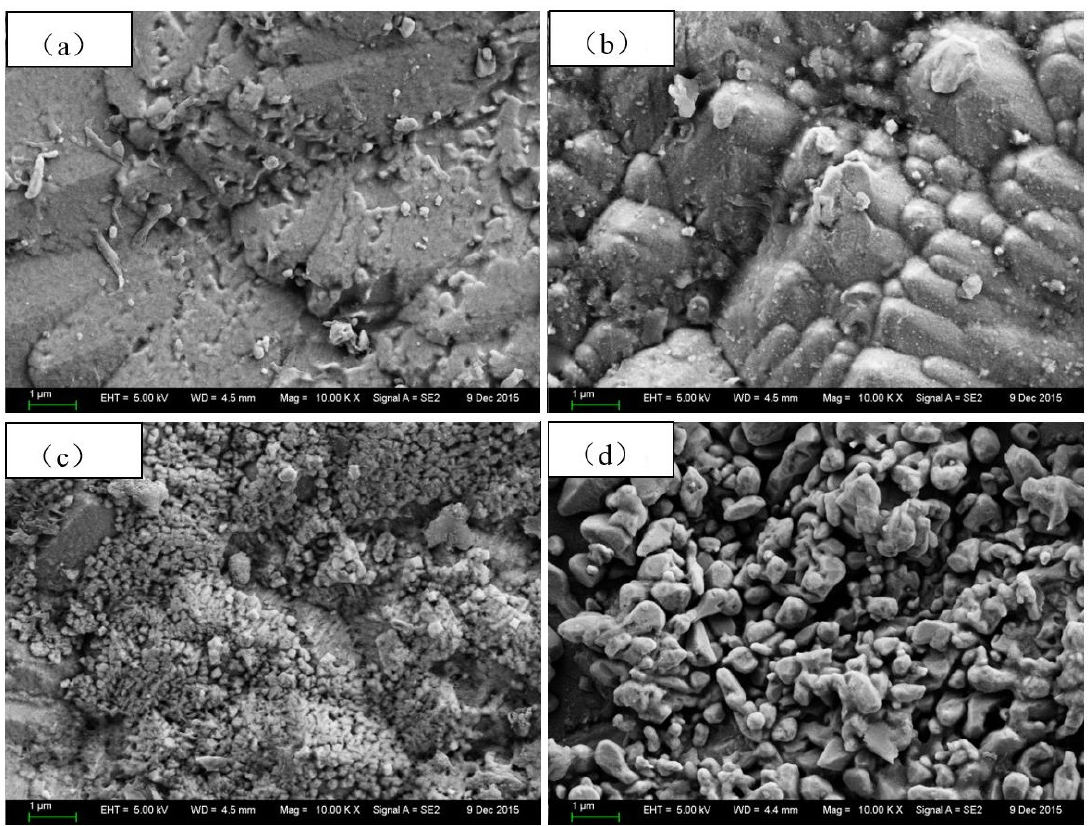
Figure 7. Morphology of the dealloying zone by SEM, ( a ) 1 week; ( b ) 2 weeks; ( c ) 4 weeks; ( d ) 8 weeks. Table 4. Contents of different element of the re-precipitated particles by EDS (wt%). Element